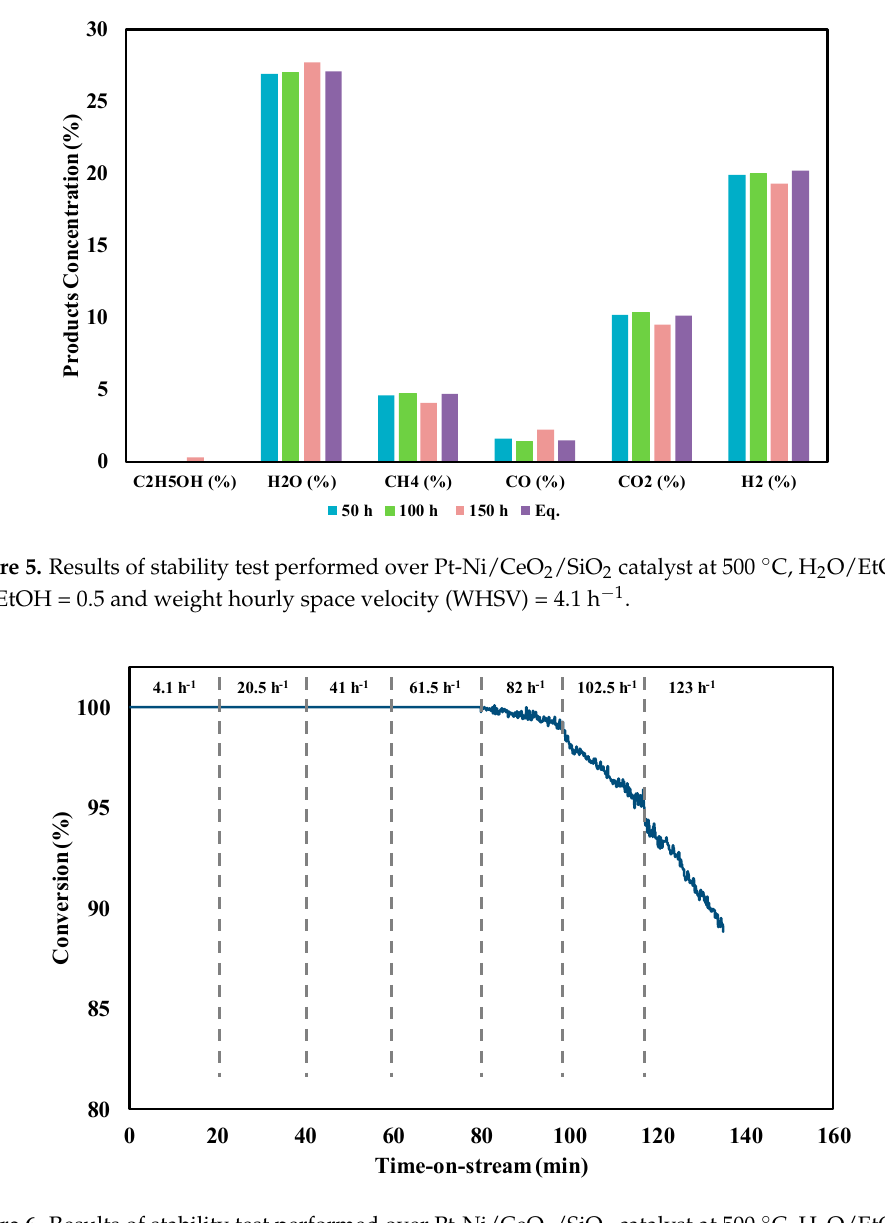
Figure 7. Ethanol conversion ( a ) and pressure drops profile ( b ) over Pt ‐ Ni/CeO 2 /SiO 2 catalyst at 500 °C, H 2 O/EtOH = 4, O 2 /EtOH = 0.5 and WHSV = 123 h − 1 . Moreover, it is worthwhile noting that several authors [15,65,69], reporting OSR tests for WHSV in the range 40–70 h − 1 , measured CFR as higher or comparable (1.3 × 10 − 4 and 6.9 × 10 − 5 g coke ∙ g c,fed − 1 ∙ g cat − 1 ∙ h − 1 ) to the value recorded over the Pt ‐ Ni/CeO 2 ‐ SiO 2 catalyst at 123 h − 1 . The influence of space velocity on CFR can be explained considering that the low contact time is responsible for a reduced extent of coke gasification reaction, per se already slower than the reactions in gaseous phase due to its heterogeneous nature [70]. The above result demonstrates the promising stability behavior of the bimetallic formulation.